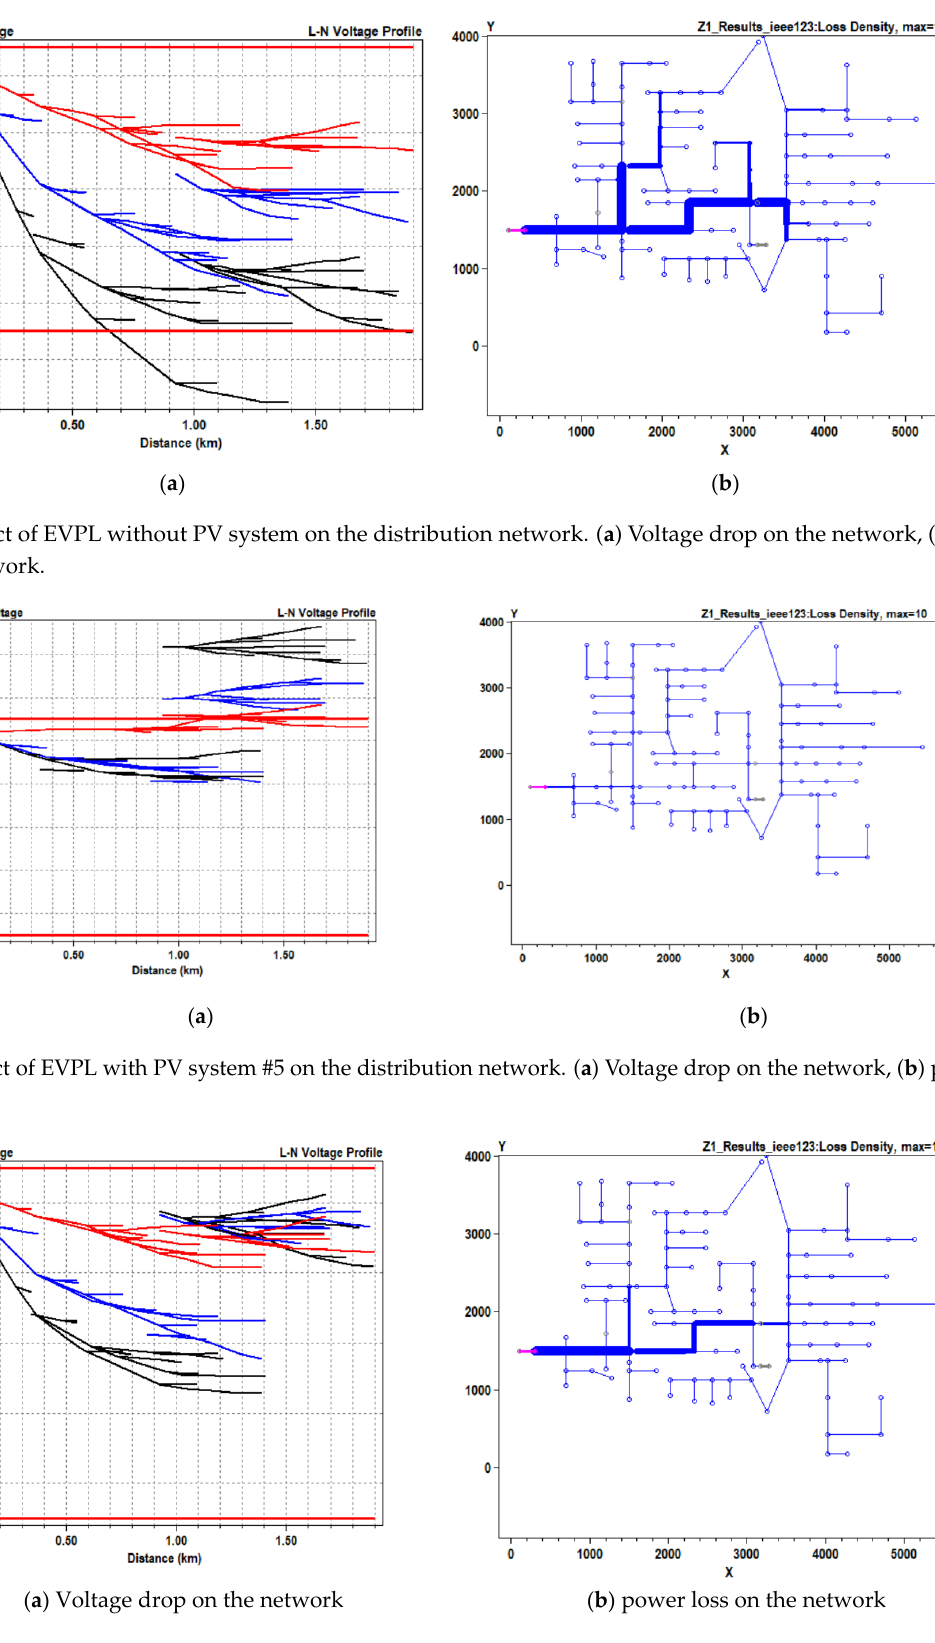
Figure 15. Impact of EVPL with PV system #11 on the distribution network. ( a ) Voltage drop on the network, ( b ) power loss on the network.